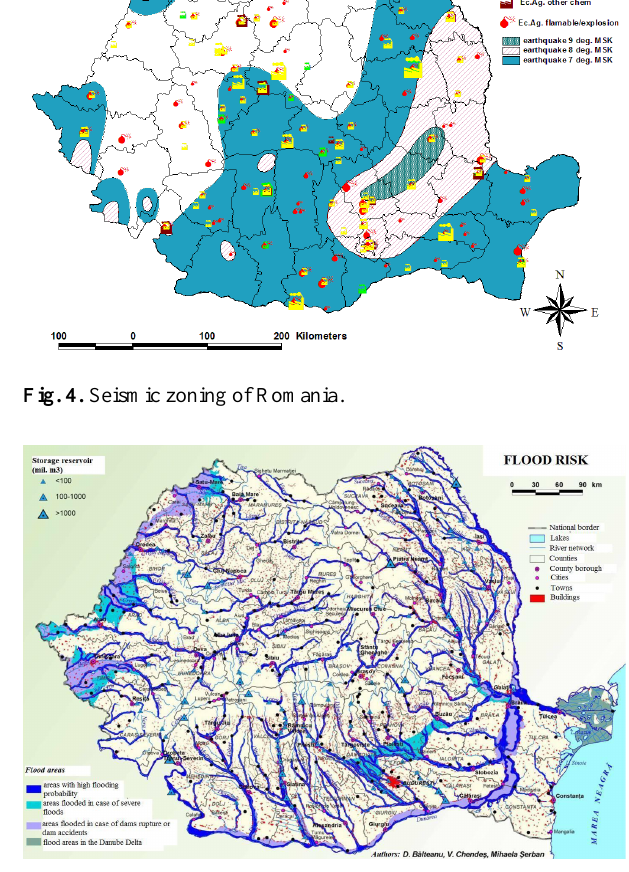
Fig. 5. Flood risk map of Romania (Bˇalteanu et al., Figure 5. Flood risk map of Romania ( Bălteanu et al., 2007 ) 3